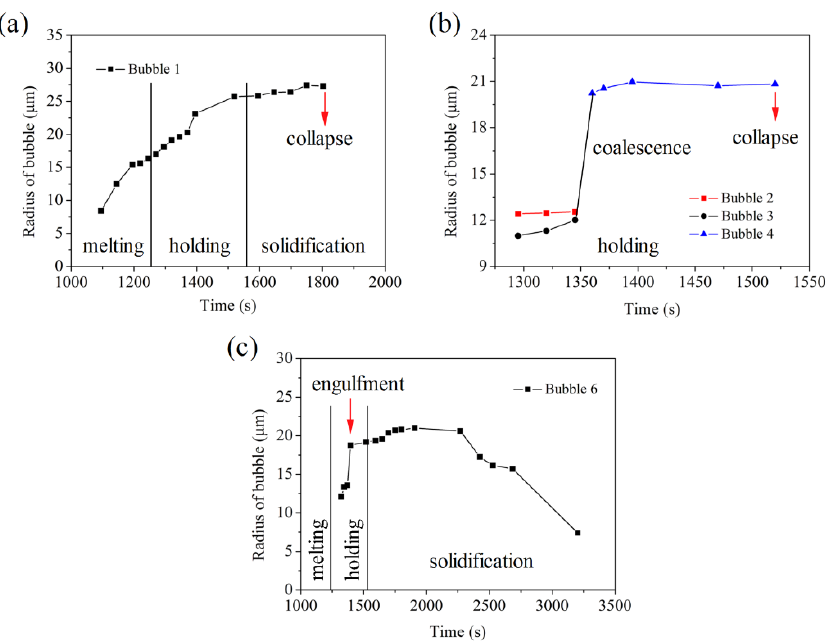
Figure 4. The variation of the radius of bubbles with time. Bubbles grow up through ( a ) diffusion, ( b ) coalescence and ( c ) engulfment.